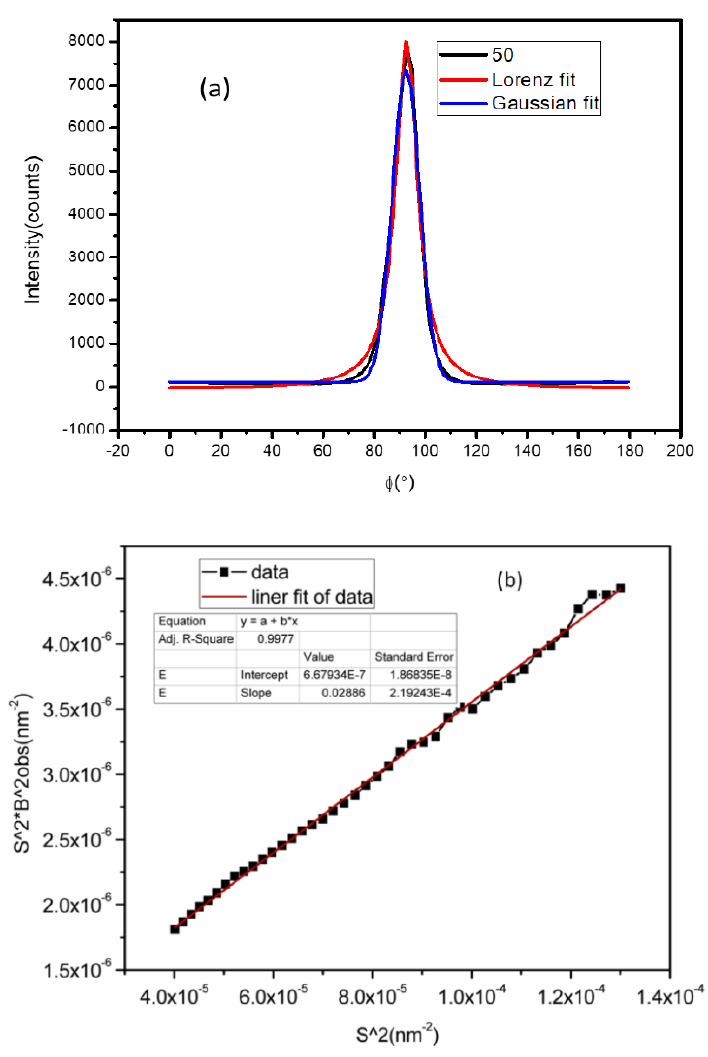
Figure 3. Representative azimuthal scans of the equatorial streak from the Kevlar49 Fibers ( a ) and the plots 𝑠 (cid:2870) 𝐵 (cid:3042)(cid:3029)(cid:3046)(cid:2870) vs s 2 for Kevlar 49 fiber ( b